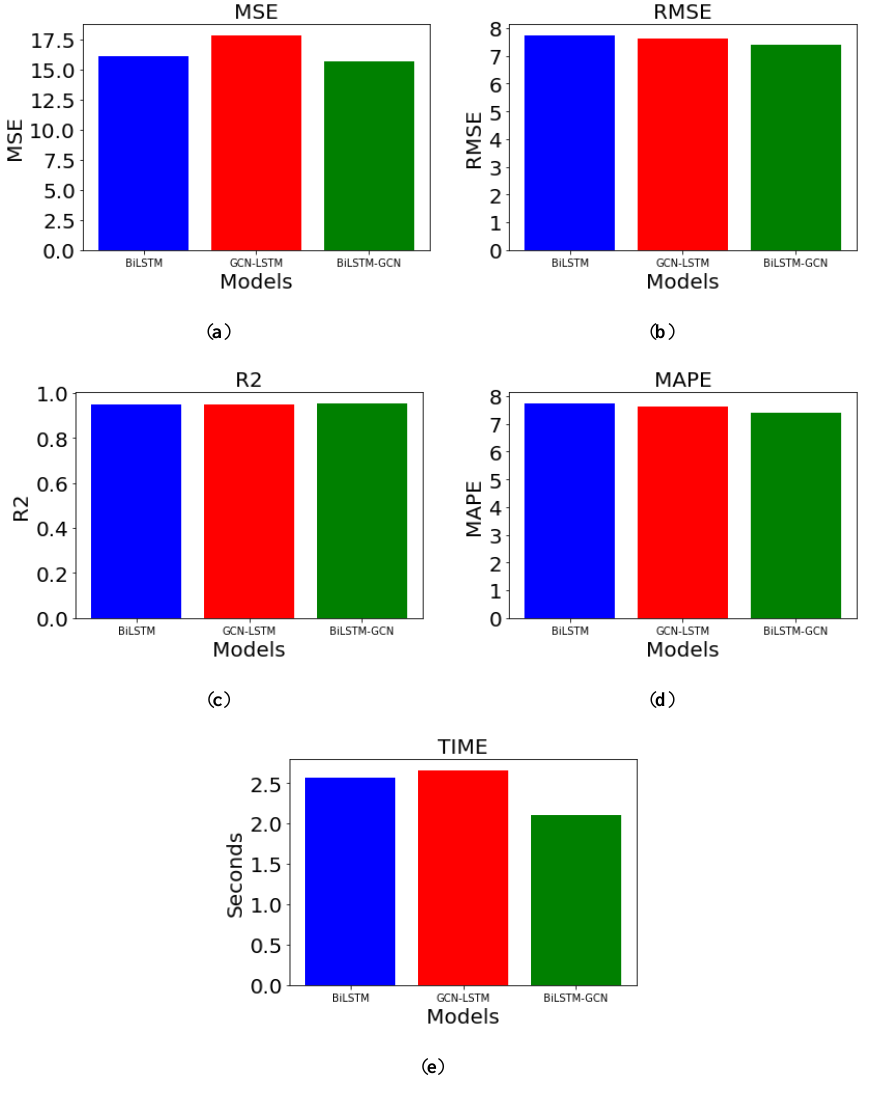
Figure 7. Comparison of models’ performance: ( a ) MSE; ( b ) RMSE; ( c ) R2; ( d ) MAPE; ( e ) Time.